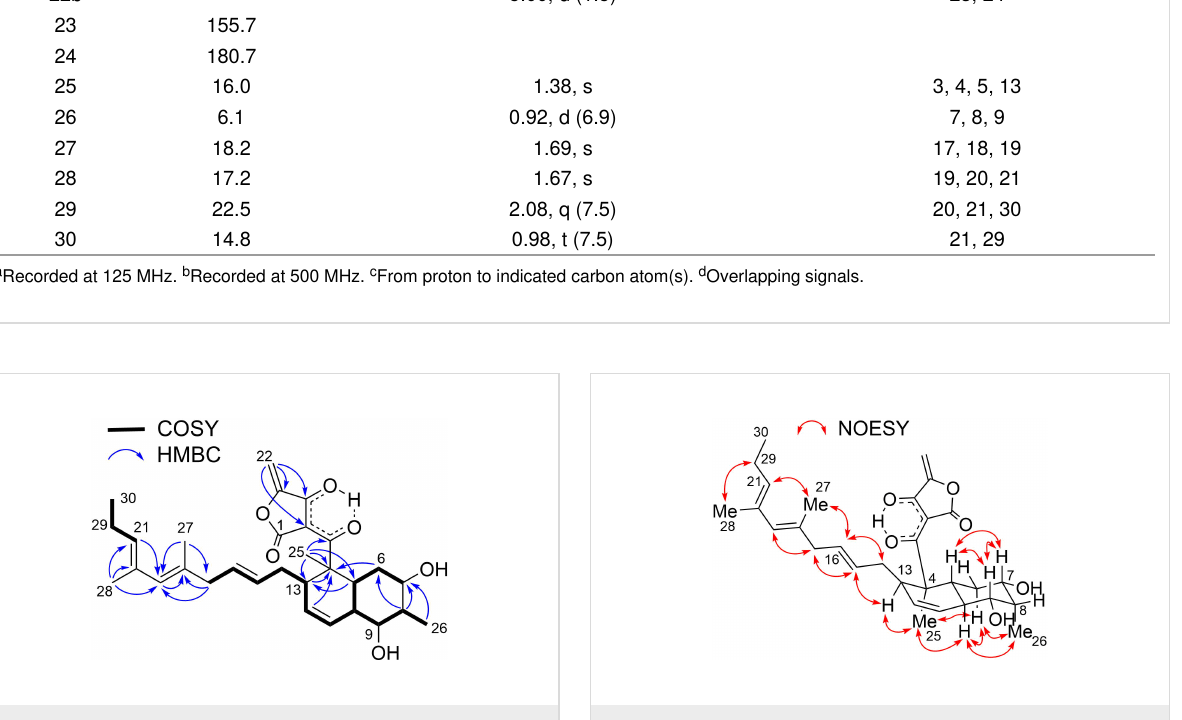
Figure 6: COSY and key HMBC correlations for 3 . Figure 7: Relative configuration of 3 determined by NOESY